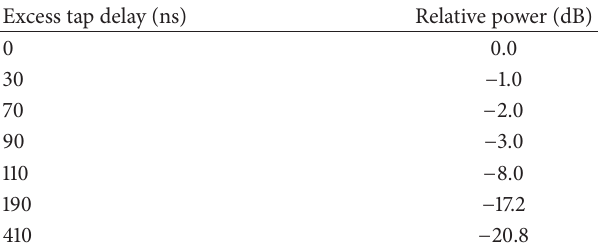
Table 2: Extended Pedestrian A channel